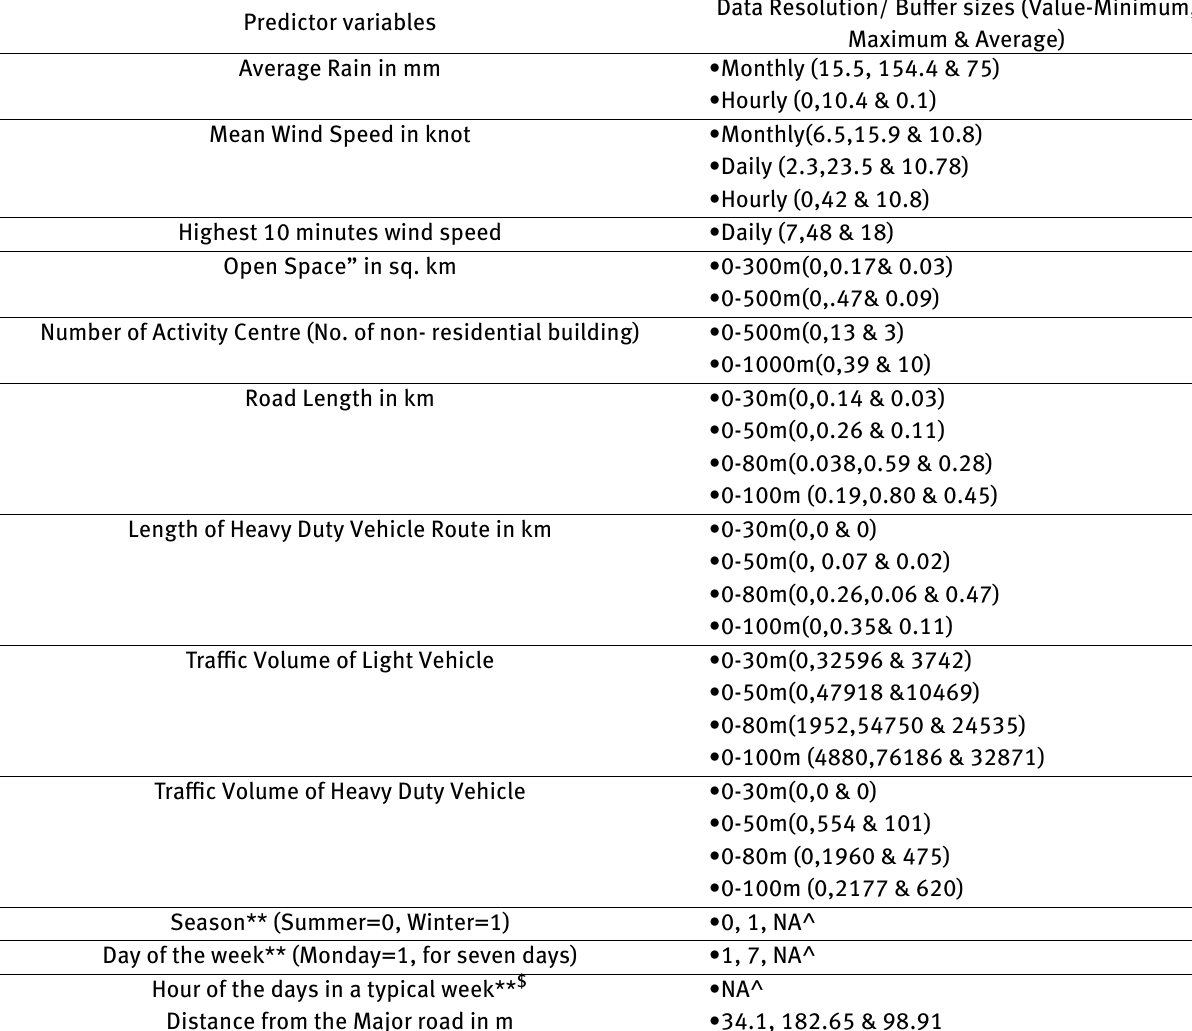
Supplementary Table 2: List of predictors assessed for the model